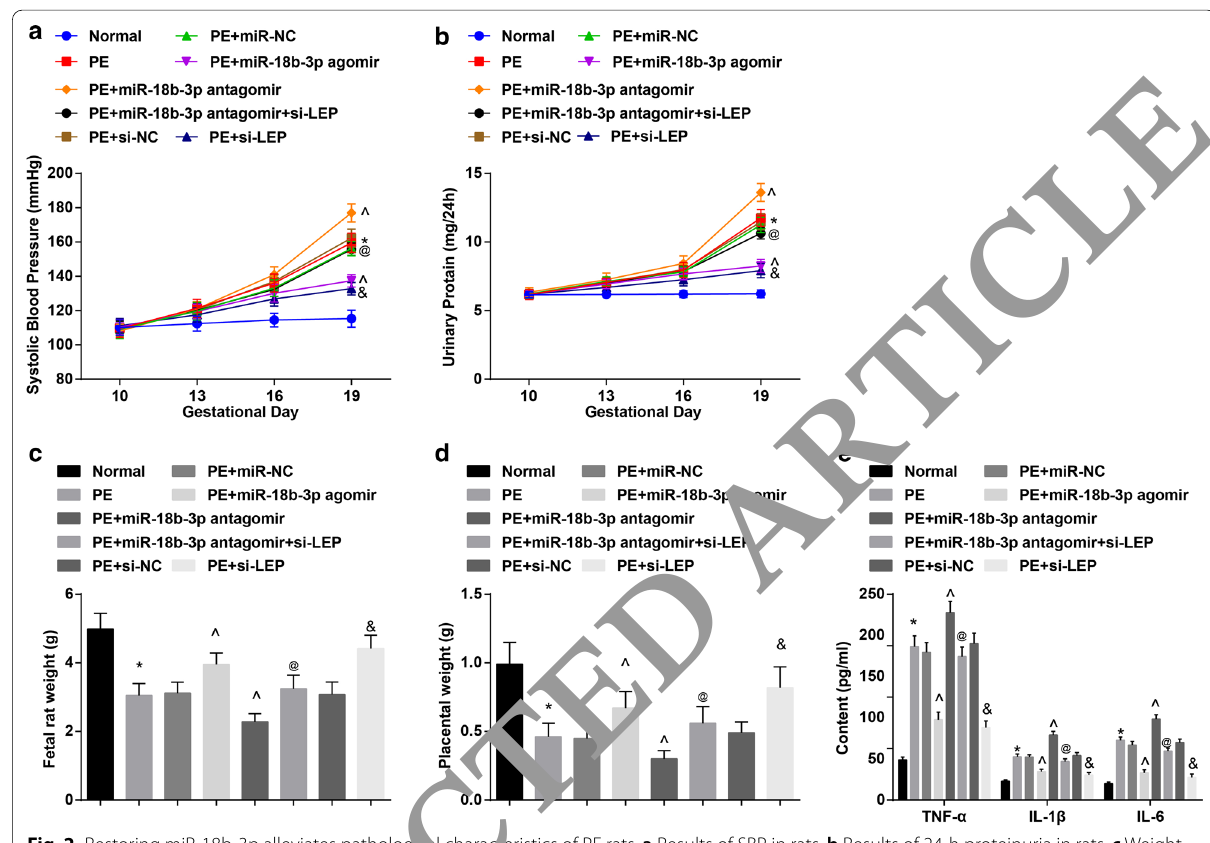
Fig. 2 Restoring miR-18b-3p alleviates pathological characteristics of PE rats. a Results of SBP in rats. b Results of 24-h proteinuria in rats. c Weight changes of fetal rats. d Changes of placental weight in rats. e Changes of inflammatory factors in serum were detected using ELISA. n versus the normal group. ^ p < 0.05 versus the PE PE si-NC group. Measurement data were depicted as mean + one-way ANOVA followed by Tukey’s